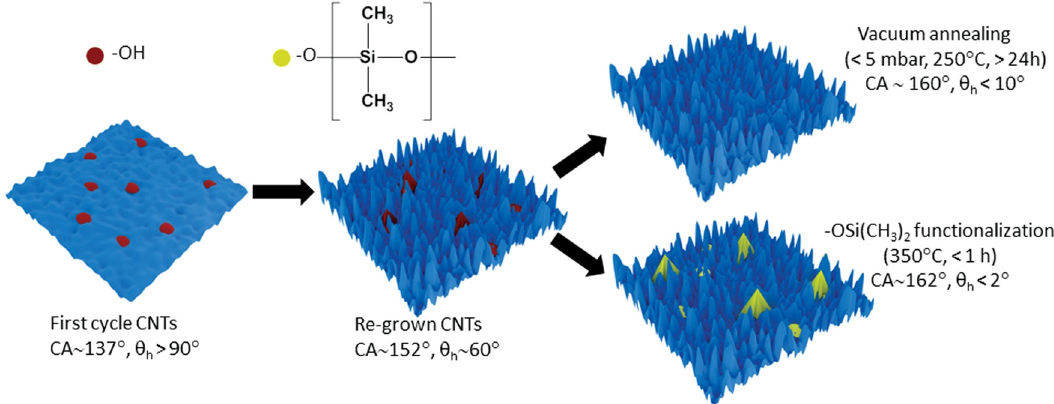
Figure 3: Schematic of the process. The regrowth CVD process increased the roughness of the CNT surface. Hydrophilic groups in the re - grown CNTs are removed by either vacuum annealing or silane modi fi cation ( θ h corresponds to CAH ) [ 77 ] . Reproduced with permission from ref. [ 77 ] ; © 2014 WILEY - VCH Verlag GmbH & Co. KGaA,